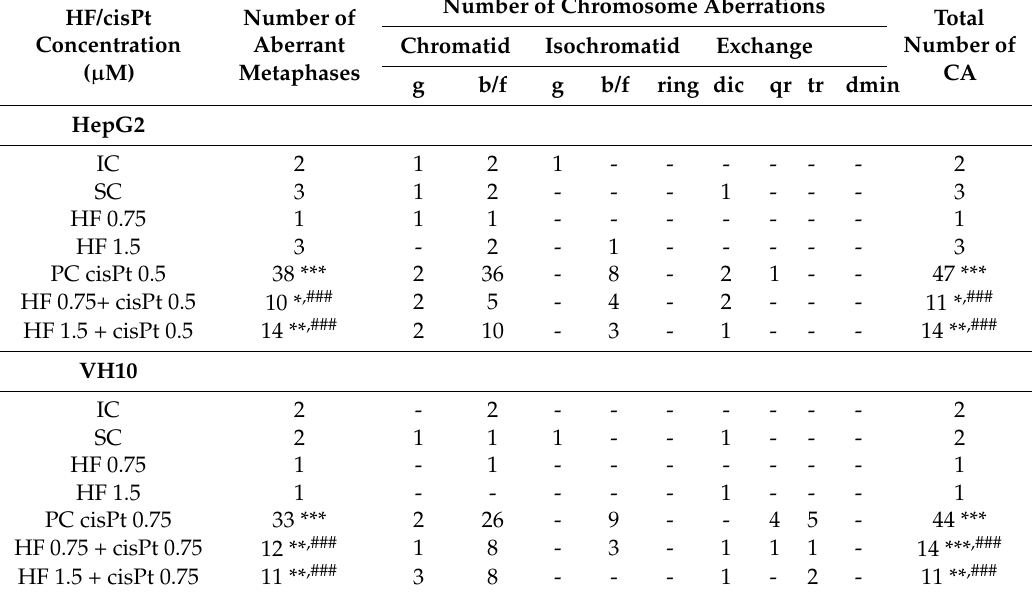
Table 2. Determination of HF anticlastogenic effect towards cisplatin using the chromosome aberration test on HepG2 and VH10